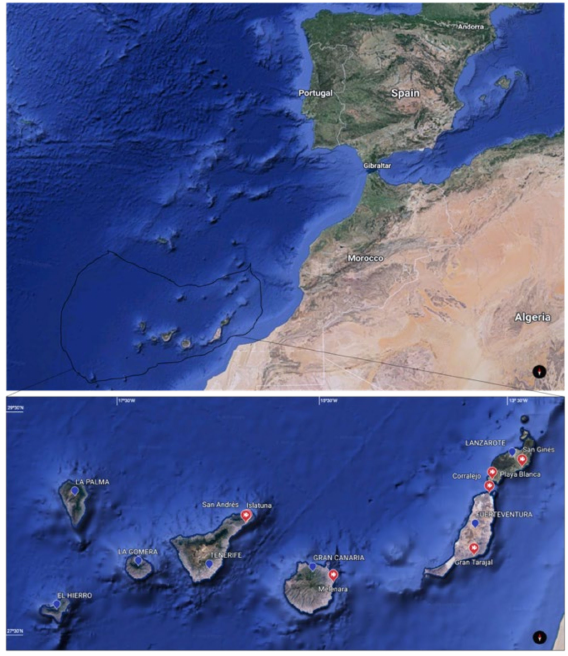
Figure 1. Spain established Exclusive Economic Zone in the Eastern Central Atlantic Ocean [31]. Inset: Capture zones in the Canary Islands (FAO fishing areas 34.1.2) [32] (maps obtained by Google Earth). Total length (cm) and weight (kg) were measured for each specimen. Fish